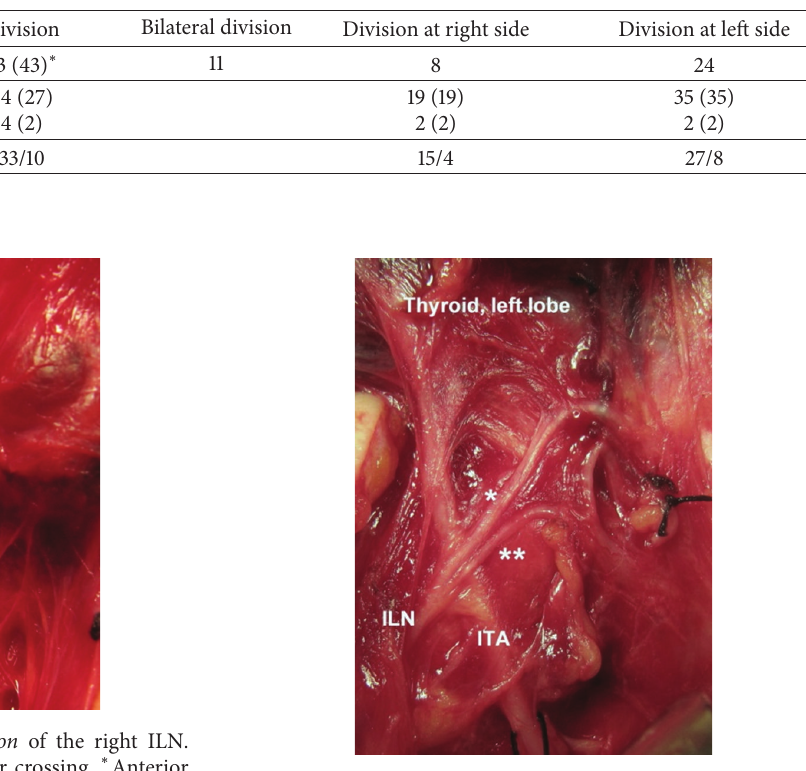
Figure 1: Segments in cervical course of the inferior laryngeal nerve (ILN). Table 2: The rate and lateral site of terminal division (bifurcation) of the inferior laryngeal nerve.